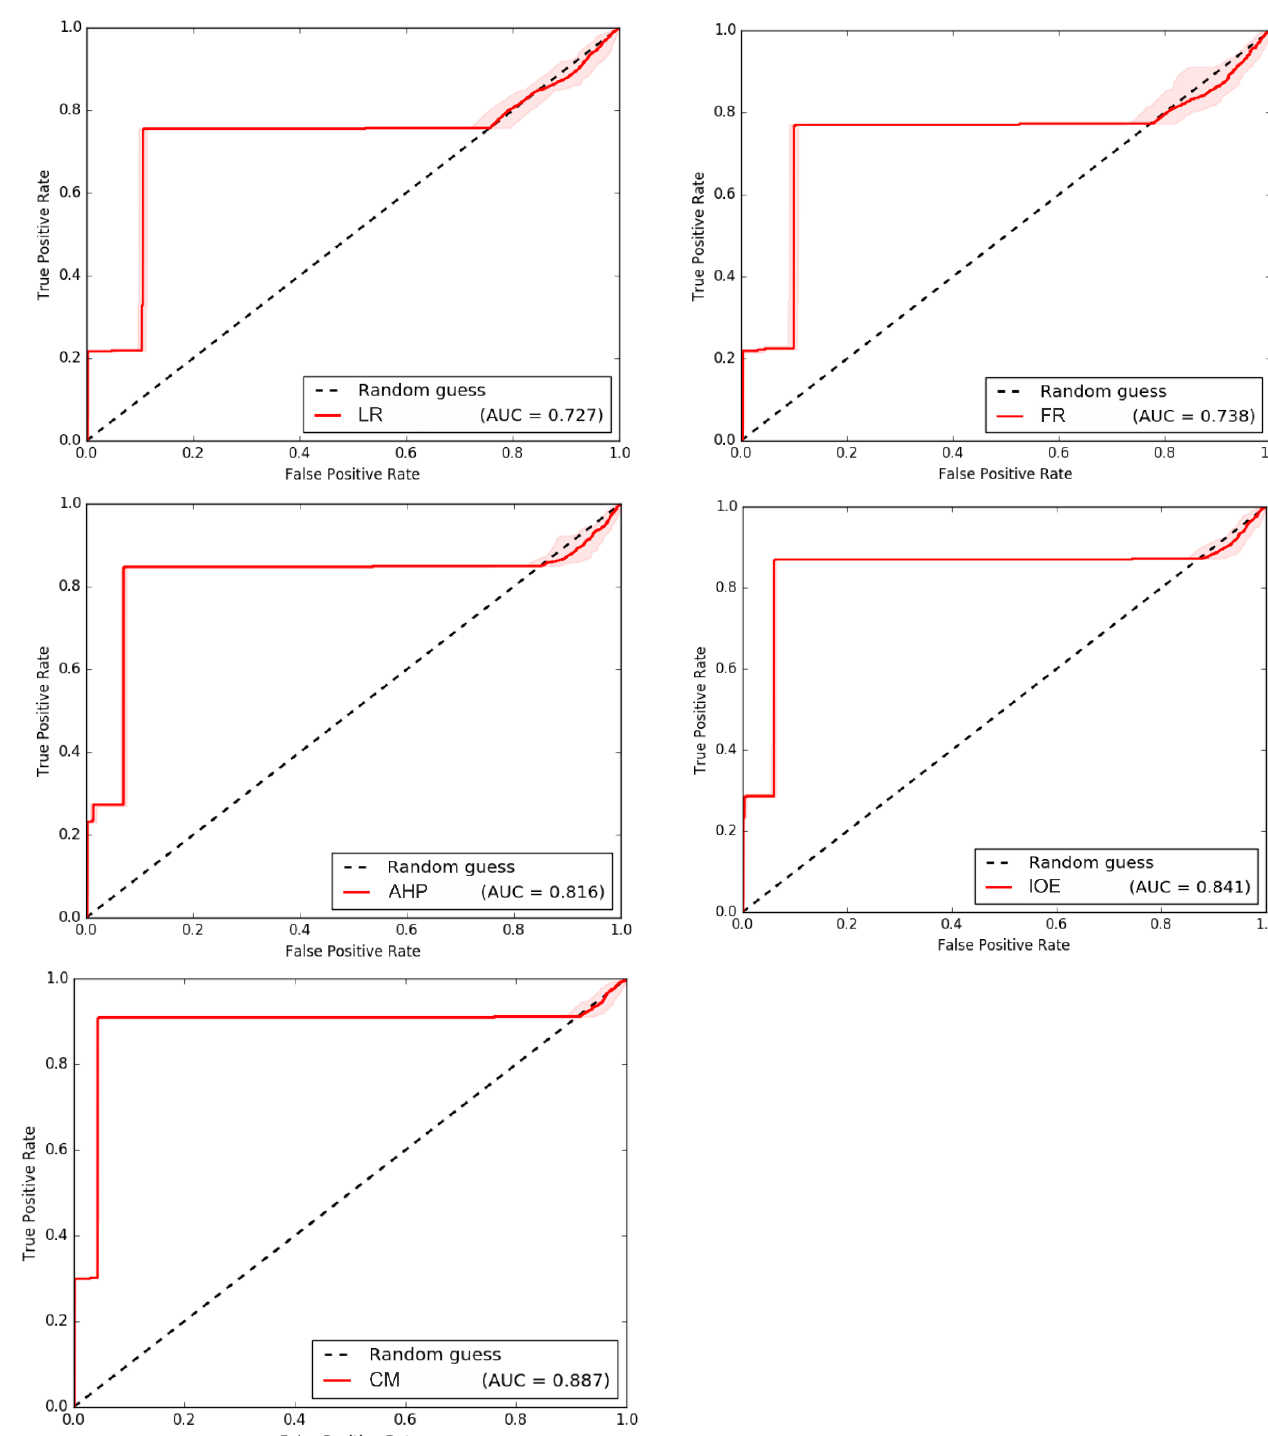
Figure 13. ROC curves of the LR, FR, AHP, IOE and CM methods.